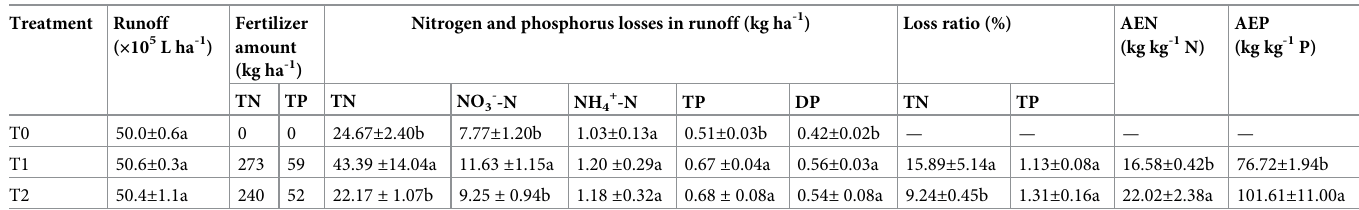
Table 3. Annual loads of nitrogen and phosphorus transported by surface runoff for the treatments T0, T1, and T2 from January to December 2018. Treatment Runoff Fertilizer ( × 10 5 L ha -1 ) amount